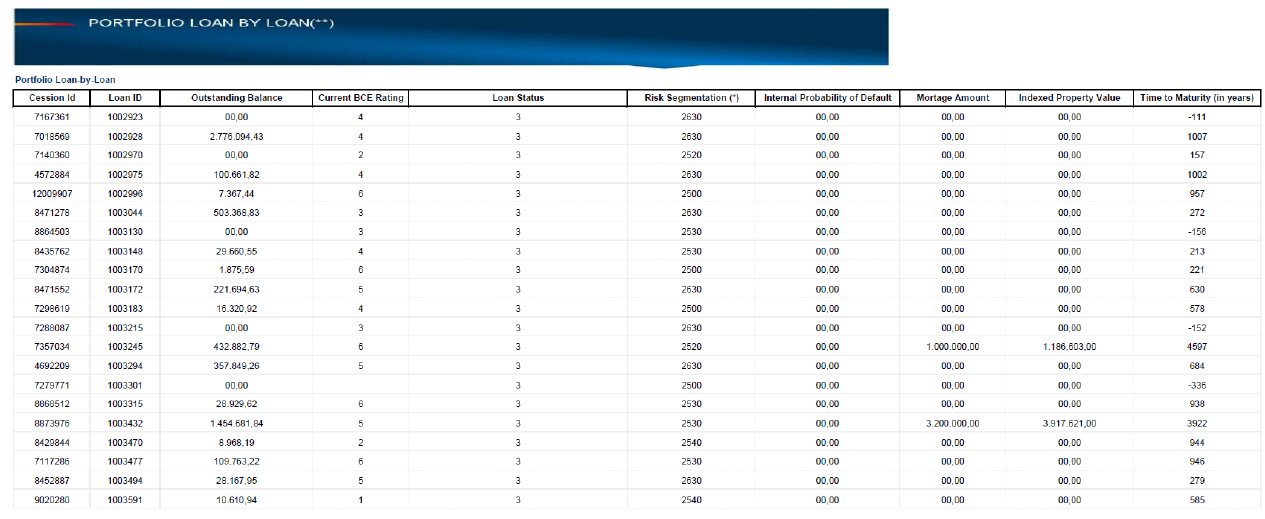
Figure 18. Example of “detail